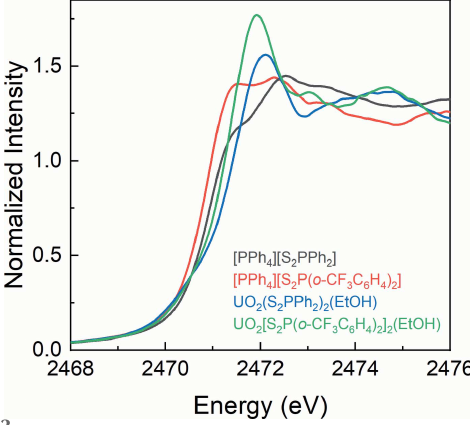
Figure 3 Comparison of the S K -edge XAS spectra of [PPh 4 ][S 2 P R 2 ] and UO 2 (S 2 P R 2 ) 2